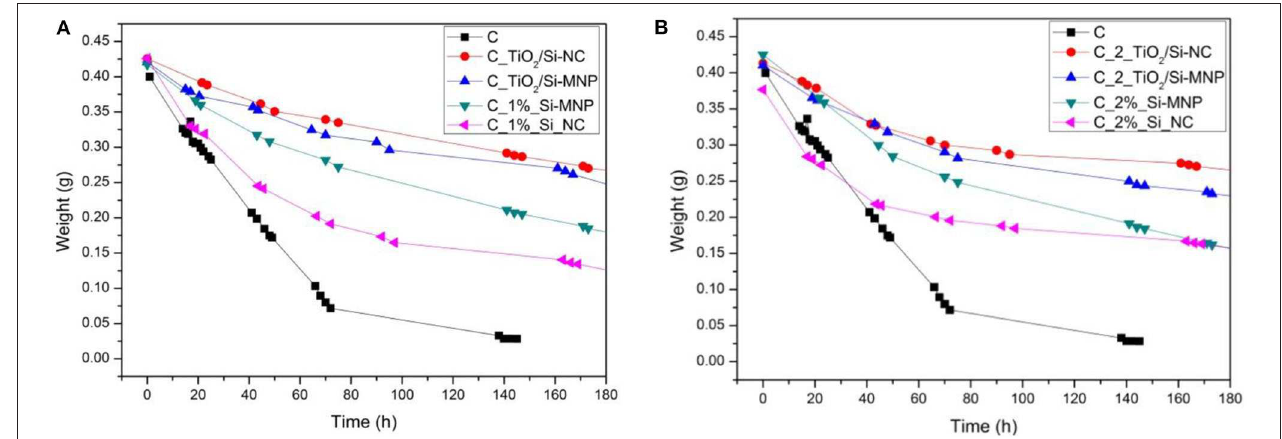
FIGURE 1 | Weight loss during the sol-gel process for the coating with 0.1% (A) and 0.2% (B) of fillers,